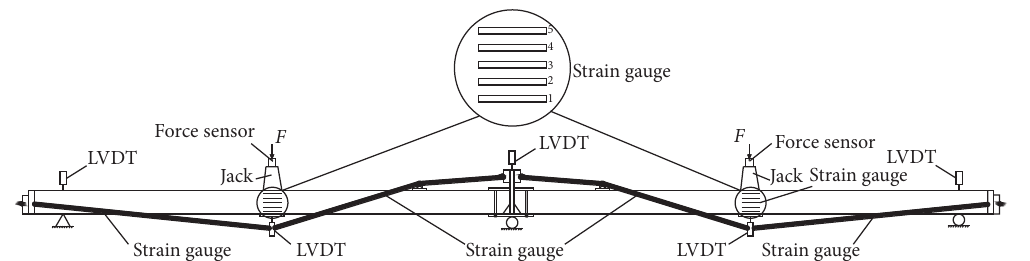
Figure 3: Adjustable prestressed continuous Glulam beam.